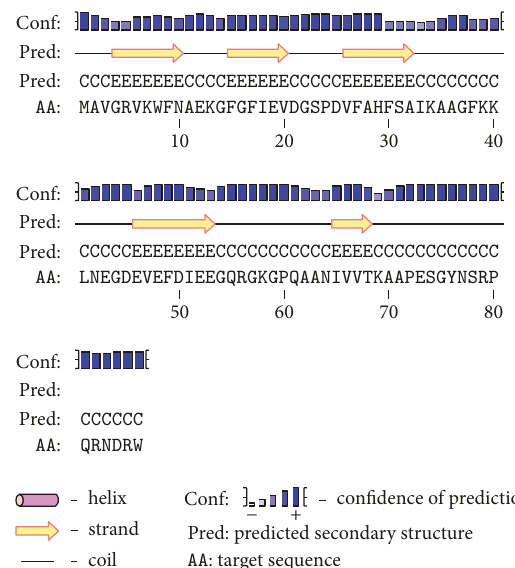
Figure 2: Secondary protein structure of Dm-Csp1 as predicted by PSIPRED . The relative height of blue bars indicates confidence of prediction.